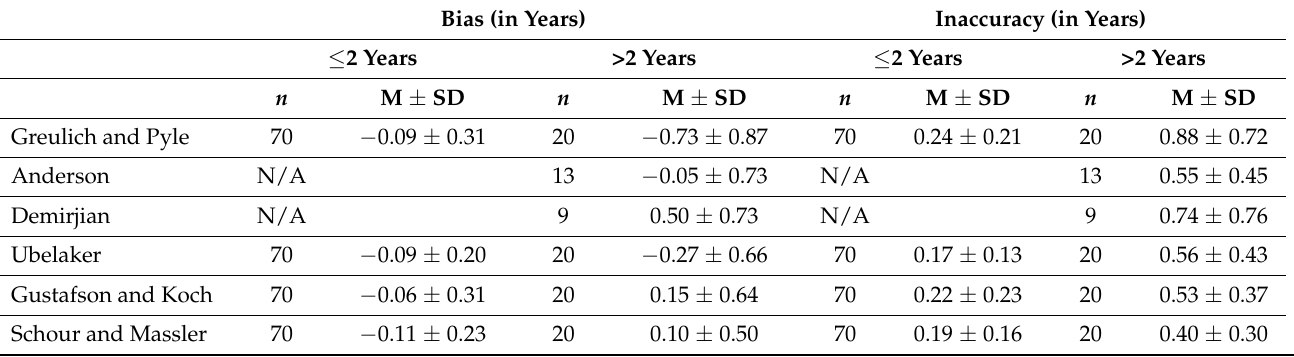
Table 3. Mean (and standard deviation) of bias and inaccuracy under and over 2 years.